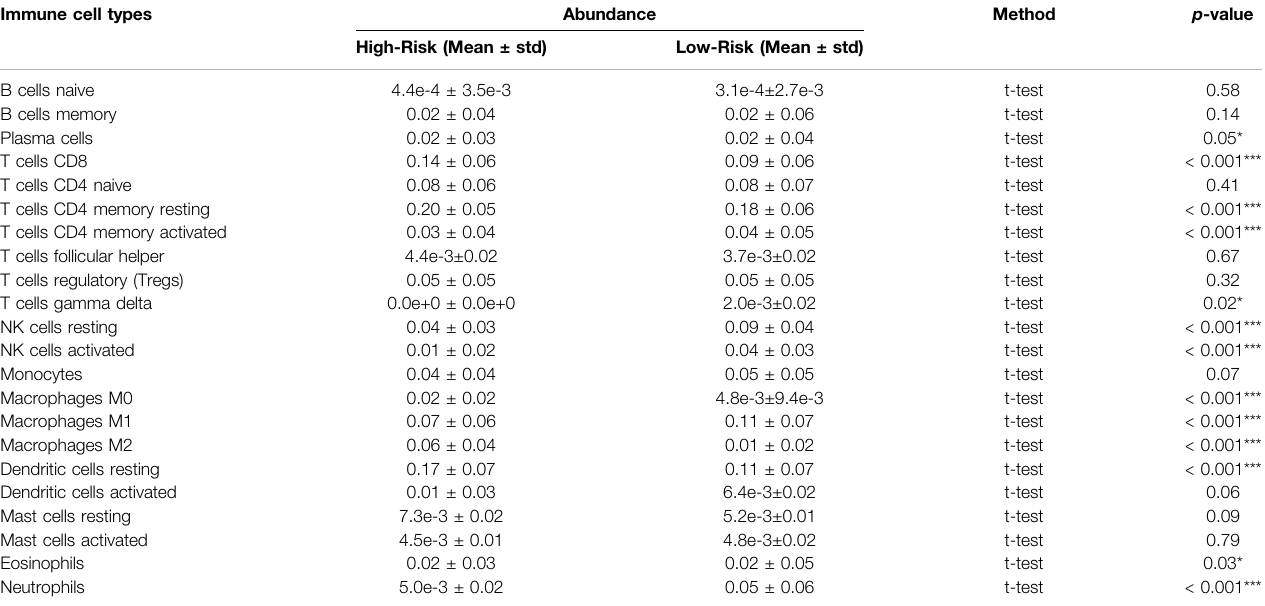
TABLE 4 | 22 Immune cell type abundance between the high-risk and low-risk groups in the entire TCGA set. TCGA, The Cancer Genome Atlas. Immune cell